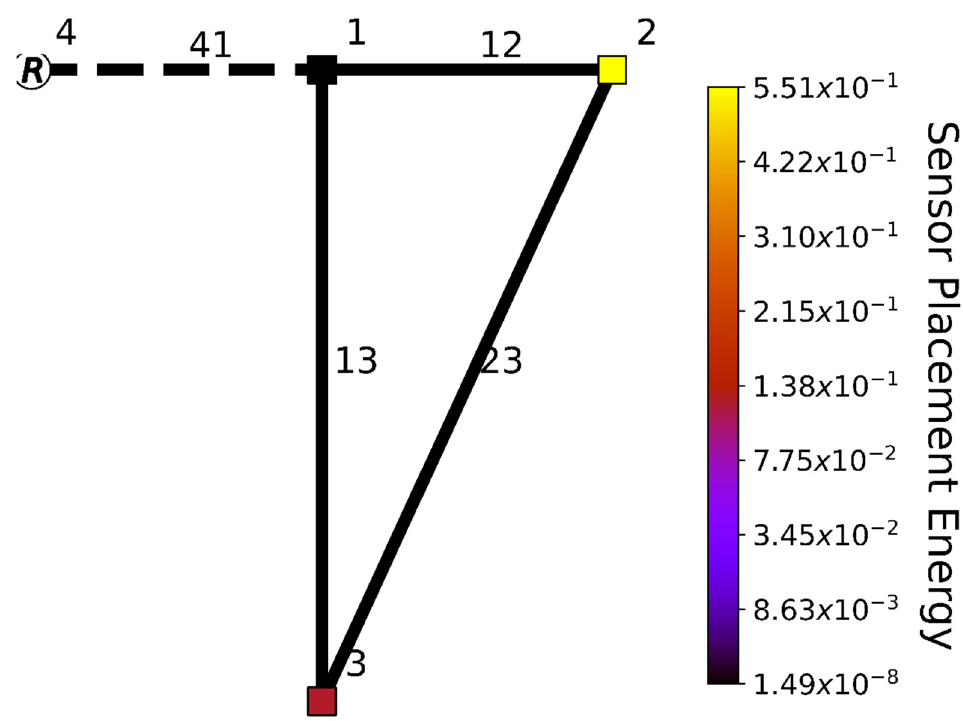
Figure 2. Triangular network, where R represents a Reservoir, squares are junctions, and lines are conduits. Black dashed are conduits. Black dashed lines indicate a conduit with a flow sensor. Each additional possible lines indicate a conduit with a flow sensor. Each additional possible sensor junction and conduit is colored based on the sensor junction and conduit is colored based on the square root of the output energy (Equation (11)), square root of the output energy (Equation (11)), corresponding with sensor placement in that specific junction or conduit. corresponding with sensor placement in that specific junction or